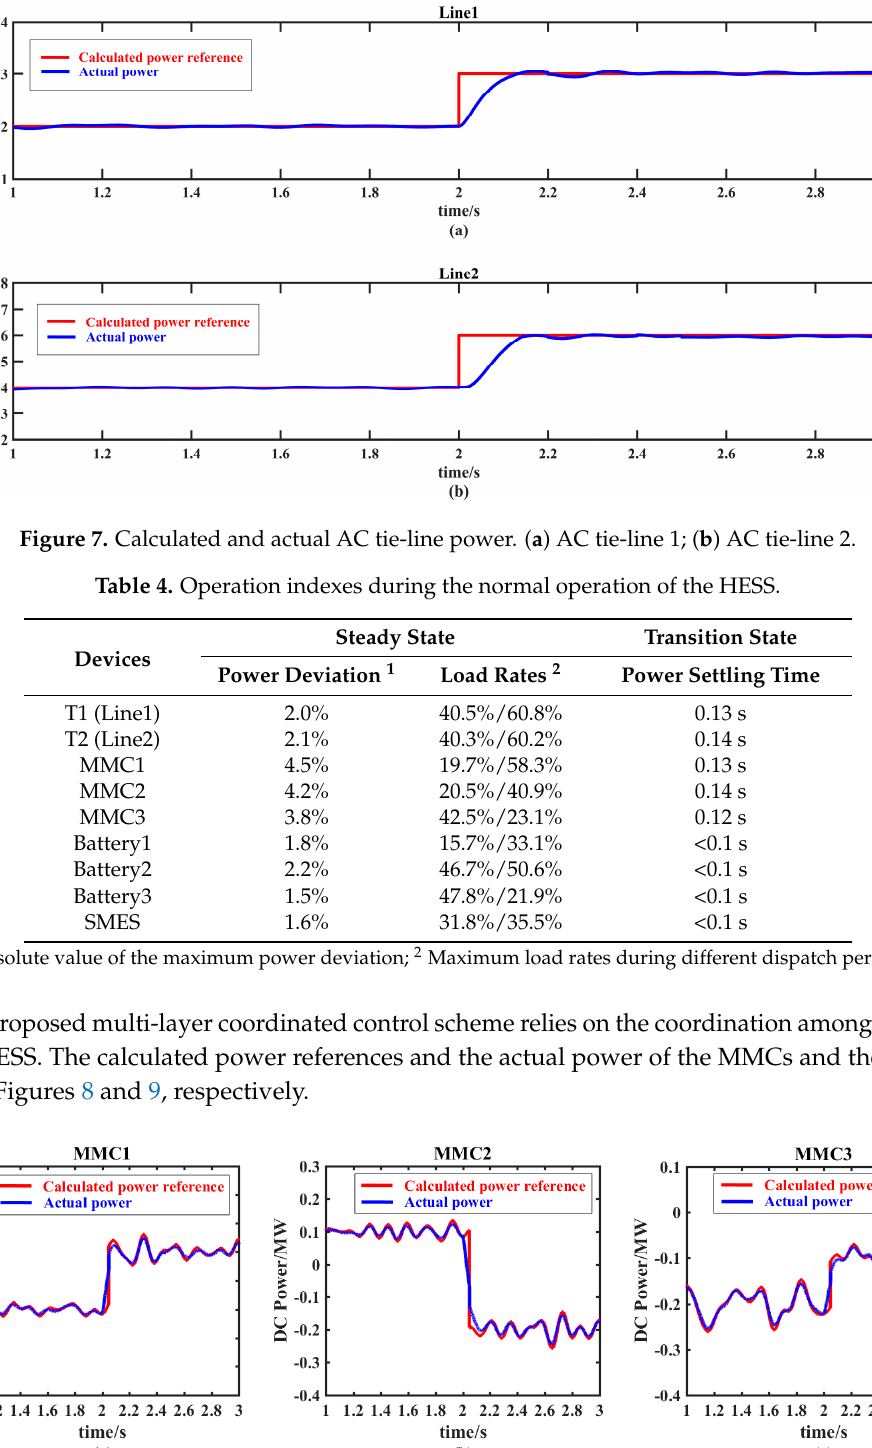
Figure 8. Calculated and actual power of the MMCs. ( a ) MMC1; ( b ) MMC2; ( c ) MMC3.